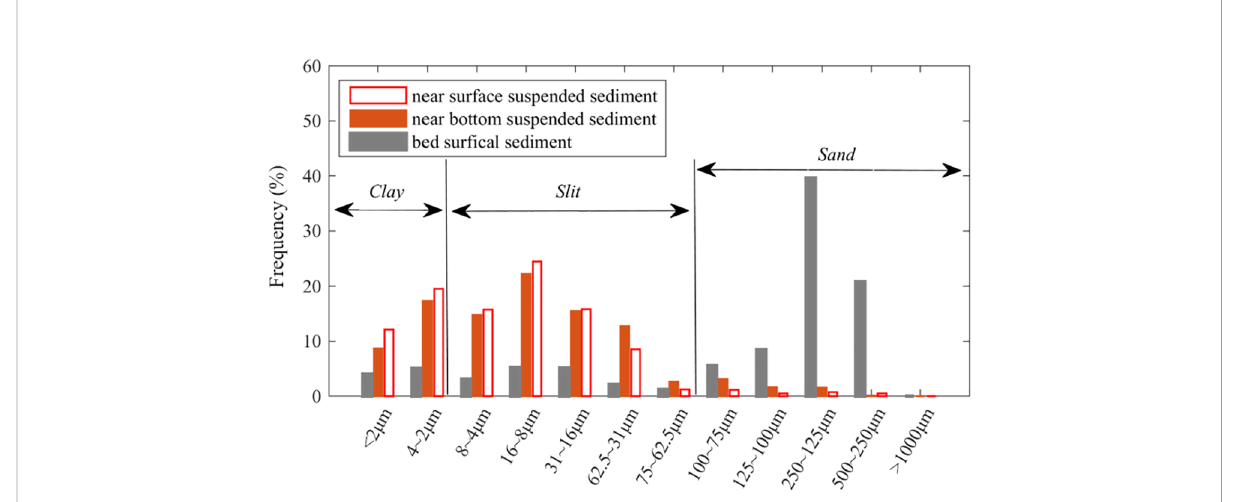
FIGURE 4 Grain size distribution of suspended sediment as well as the bed sur fi cial sediment sampled at the observation